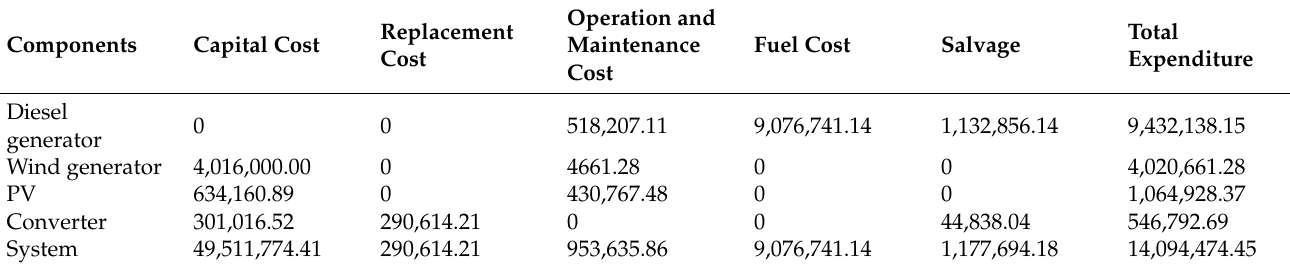
Table 11. Cost detailed of the best optimal (PV–wind–diesel) system.